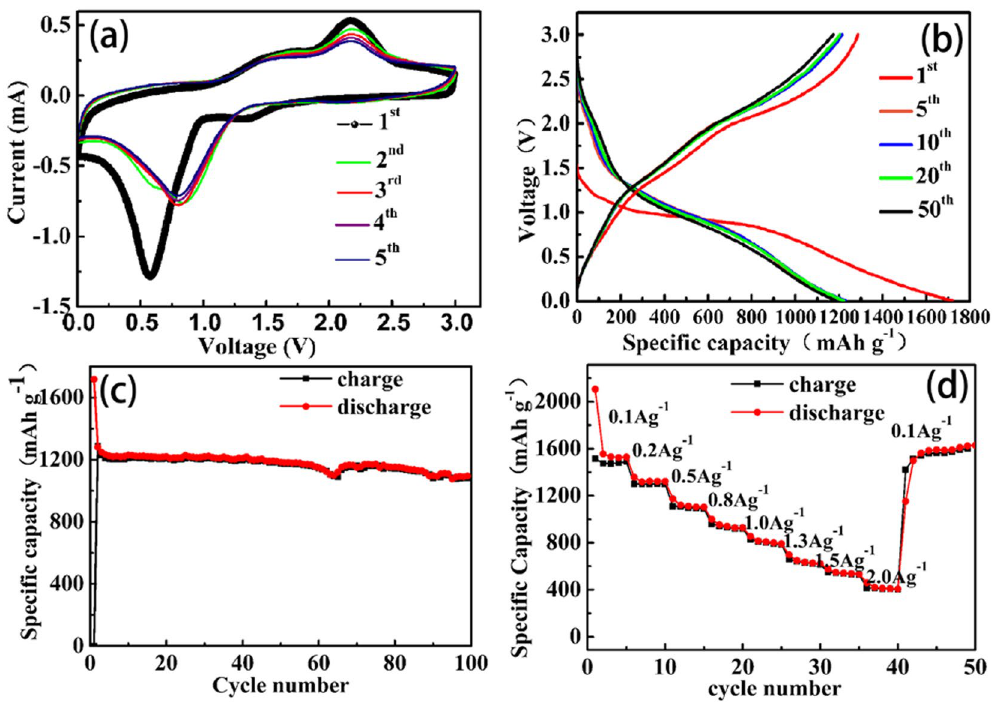
Figure 5. ( a ) Cyclic voltammograms of Co 3 O 4 /GS at 0.5 mVs − 1 ; ( b ) Charge/discharge voltage profiles and ( c ) Cycling performance of Co 3 O 4 /GS at a current density of 0.2 A g − 1 ; ( d ) Rate capability of Co 3 O 4 /GS hybrid film.